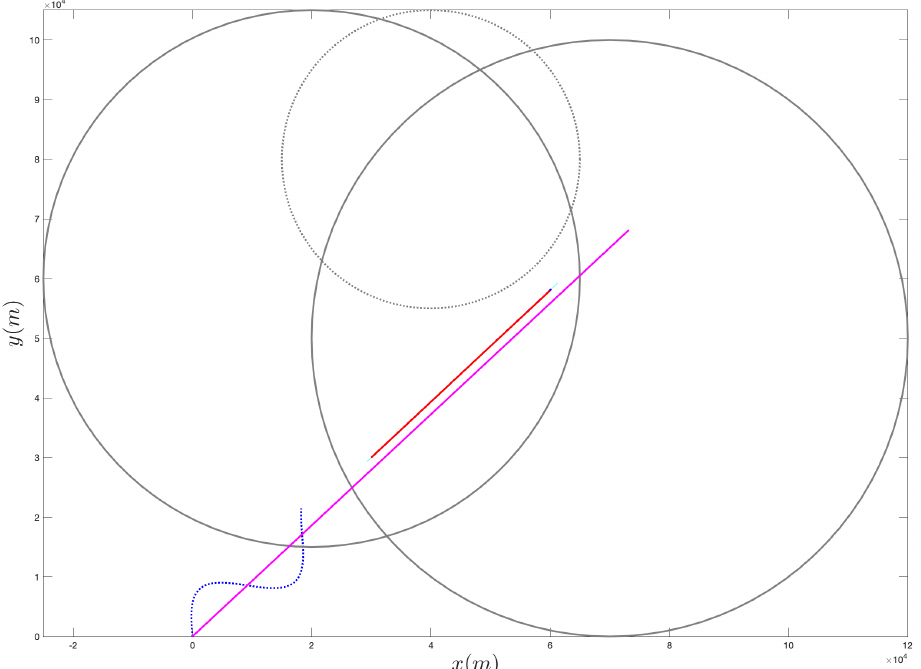
Figure 5. Sampling of 100 trajectories (cyan) based on the average solution found via the proposed approach and on the CRLB covariance